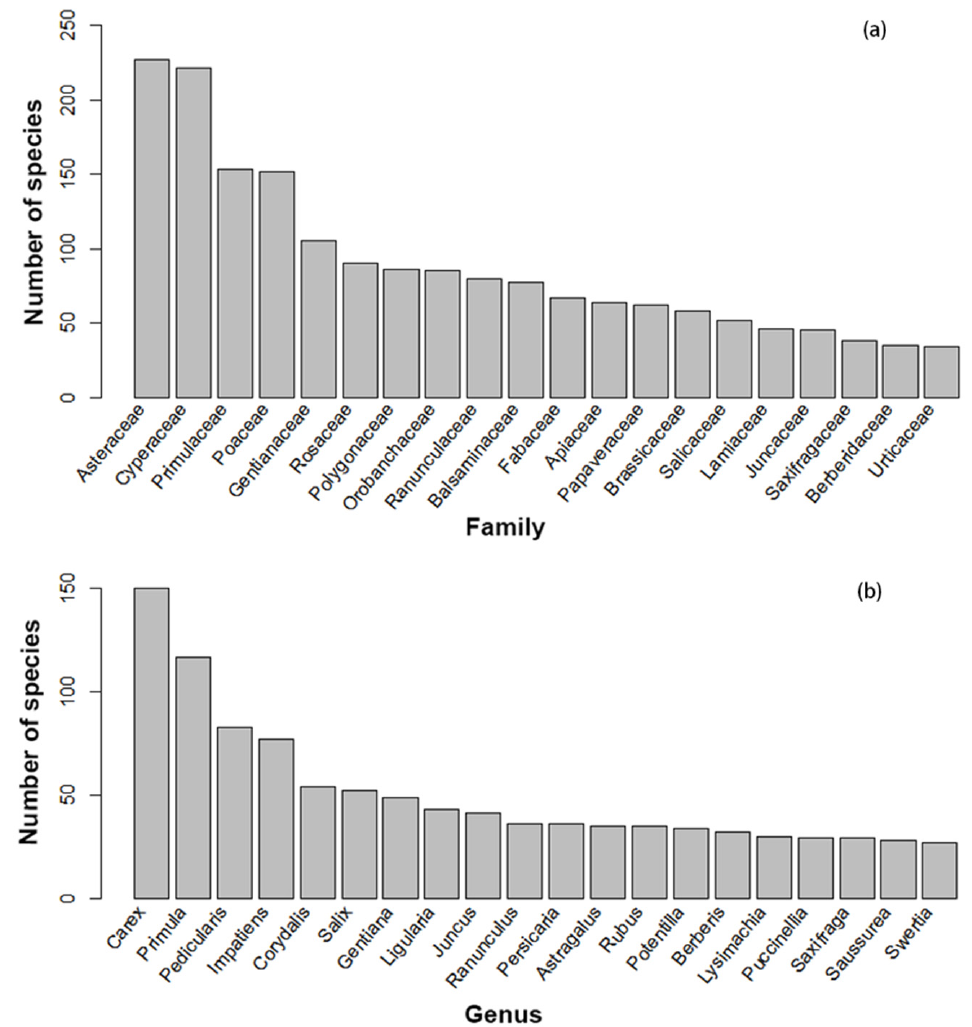
Figure 2. The top 20 species-rich families ( a ) and The top 20 species-rich genera ( b ) of wetland angiosperms in the Qinghai-Tibet Plateau.